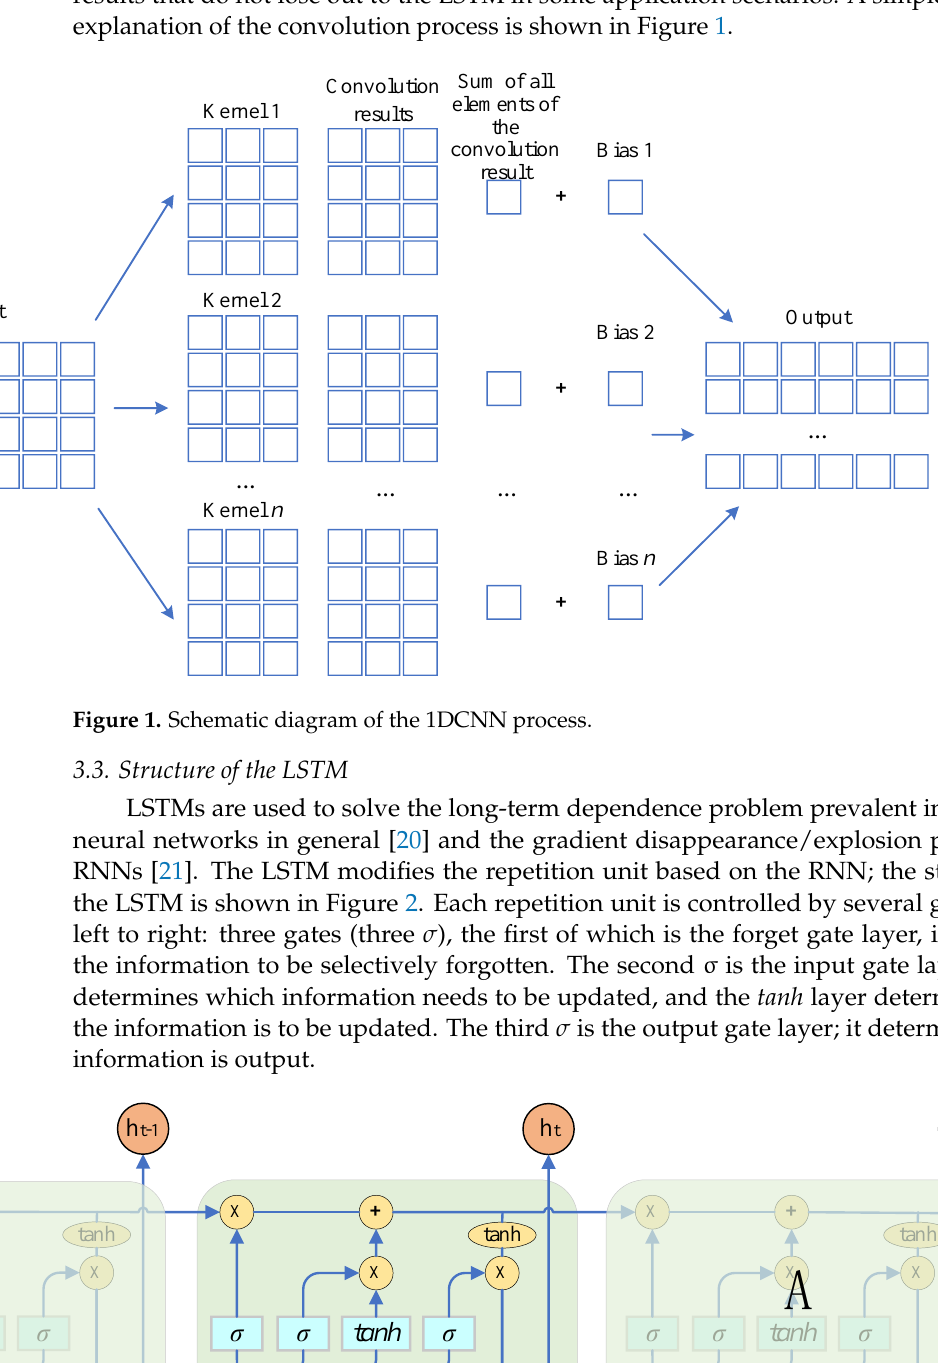
Figure 2. Structural diagram of the LSTM.